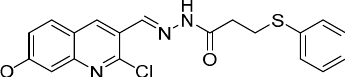
Figure 2. The structure of parent compound 15 from the WEHI screening.